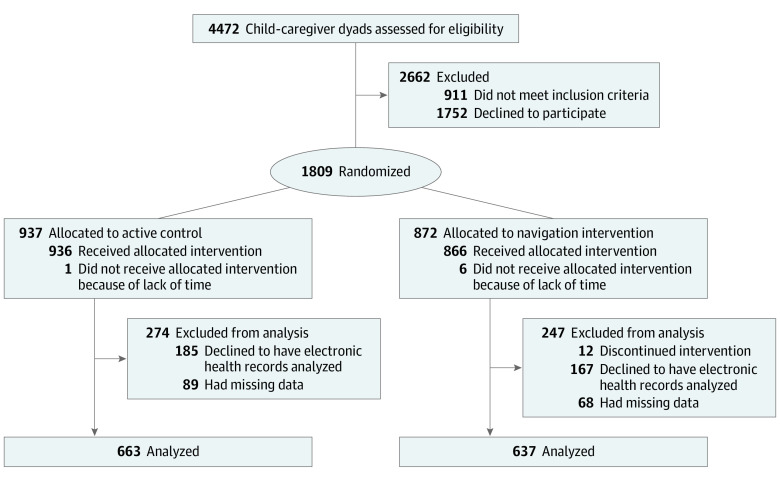
CONSORT Diagram